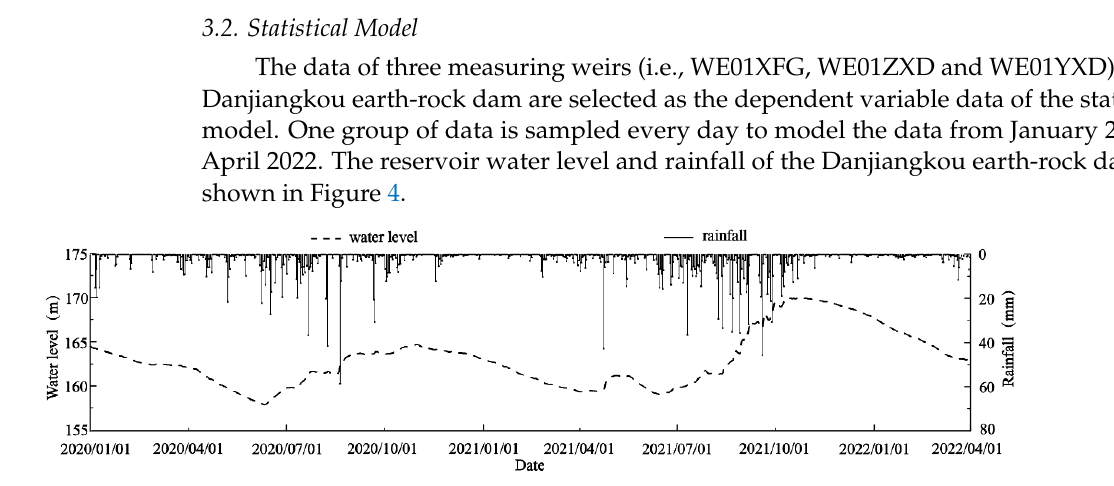
Figure 4. Reservoir water level and rainfall distribution.